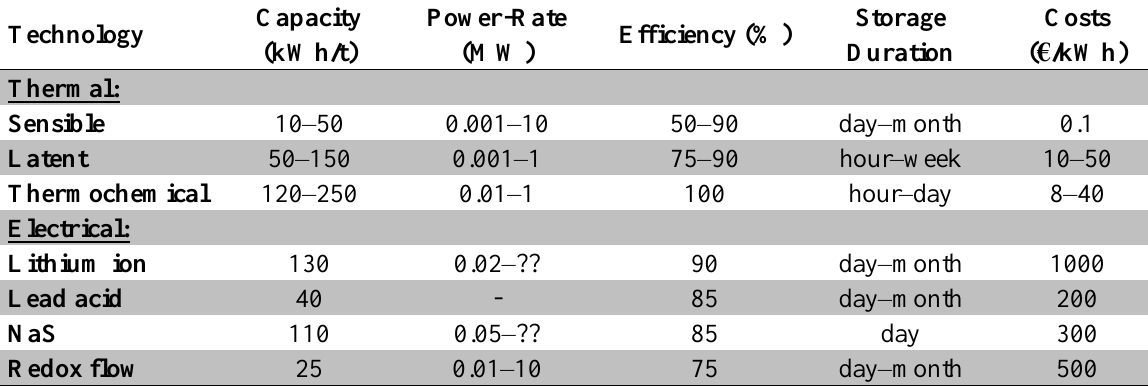
Table 1. Storage technologies with technical and economic characteristics for both thermal and electrical storages